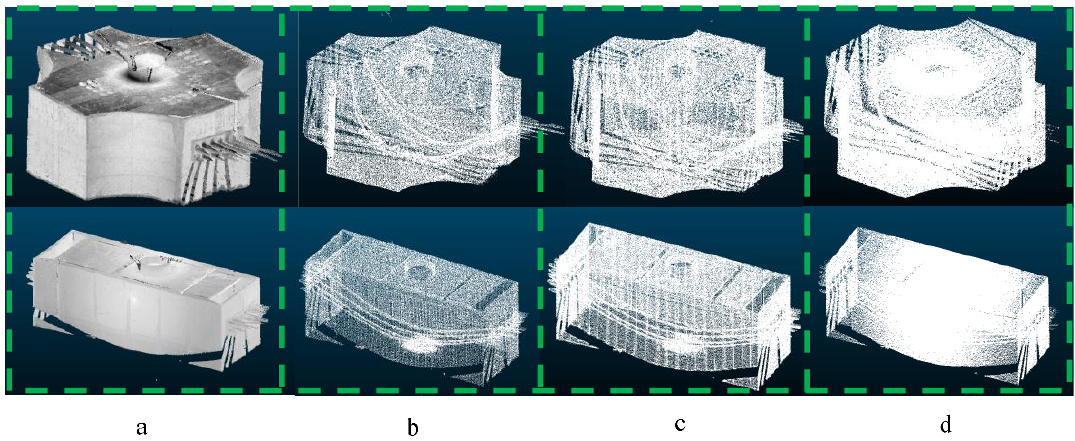
Figure 13. Effects of different simplification methods. ( a ) Original point clouds (top row represents Point Cloud 1, bottom row represents Point Cloud 2), ( b ) twice moving mesh divisions, ( c ) density-based adaptive, and ( d ) percentage.